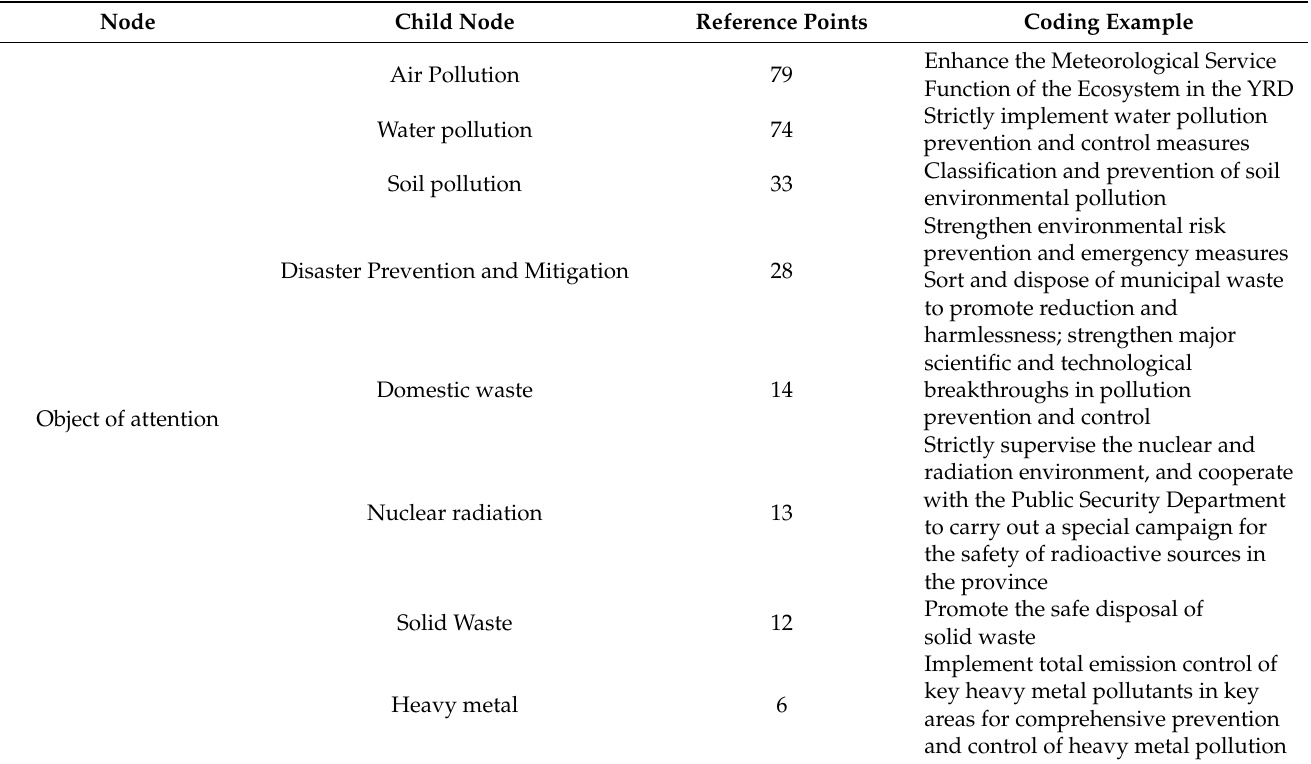
Table 3. Node hierarchy and coding information with precise pollution control “objects of